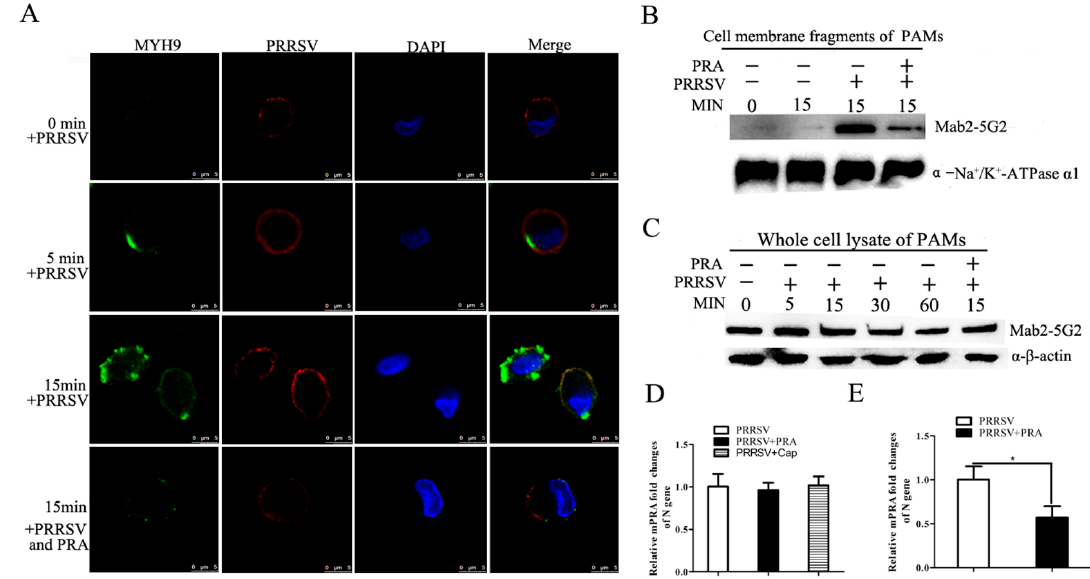
Figure 4. PRA treatment prevents both the redistribution of MYH9 to the plasma membrane and internalization of PRRSV virions. ( A ) Confocal microscopy of MYH9 redistribution from cytoplasm to membrane of PAMs with indicated treatments. PAMs were incubated with PRRSV (50 MOI) with or without preincubation with PRA (10 mg) at 4 °C for 2 h and then shifted to 37 °C. MYH9 redistribution from cytosol to plasma membrane was induced by PRRSV attachment to PAMs. All samples used here are not permeabilized by TritonX100 to maintain the integrity of plasma membrane. ( B ) PAMs were incubated with PRRSV (with or without preincubation with 10 mg PRA) with a MOI of 50 at 4 °C for 2 h followed by 15 min incubation after shifting to 37 °C, then plasma membrane fractions of PAMs from indicated groups were extracted and subjected to Western blot analysis using Mab2-5G2 for MYH9 detection. Plasma membrane protein Na + /K + -ATPase α 1 was stained with corresponding antibodies as well and included as a sample-loading control. ( C ) PAMs were incubated with PRRSV at MOI = 50 at 4 °C for 2 h followed by shifting to 37 °C, whole-cell lysates of PAMs harvested at indicated time points (0, 5, 15, 30, 60 min) after temperature shifting were harvested and analyzed for total MYH9 expression via Western blot. PAMs incubated with PRRSV- PRA mixture (50 MOI and 10 mg, respectively) followed by 15 min incubation after shifting to 37 °C was included as well; ( D ) PAMs incubated with PRA-PRRSV virion mixture or PRRSV alone at 4 °C without internalization of virus were harvested using TRIzol for relative quantification of attached virions on cell surfaces via evaluating viral RNA by qPCR. ( E ) PAMs incubated with PRA-PRRSV virion mixture or MF4 peptide-PRRSV virion mixture at 4 °C were shifted to 37 °C to trigger internalization of PRRSV virions then followed by trypsin digestion to remove un-internalized virus; samples were harvested using TRIzol for relative quantification of internalized virus via evaluation of viral RNA by qPCR. PAMs incubated with PRRSV alone were included as positive control. The data are expressed as mean ± SD and were subjected to Student’s t-test. Significant differences between the two groups are marked by “*” ( p < 0.05).